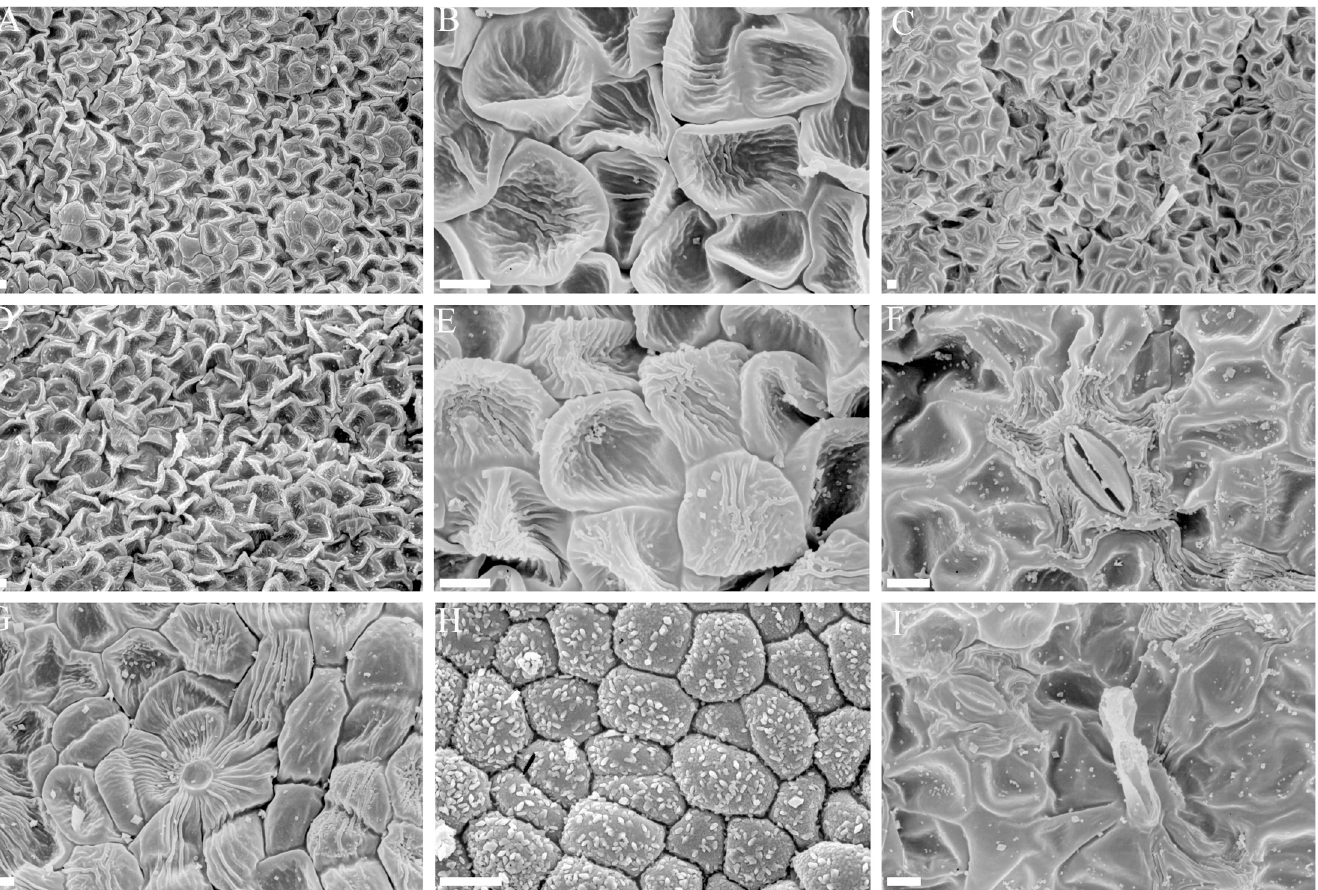
Fig 2. Scanning electron microscope micrographs of green bracts and white bracts. A) Adaxial surface of green bract. B, C) Abaxial surface of green bract. D, E, F, I) Abaxial surface of white bracts. G, H) Adaxial surface of white bract. Scale bars for A, C, D and G equal 100 μ m, and scale bars for B, E, F, H and I equal 10 μ m.